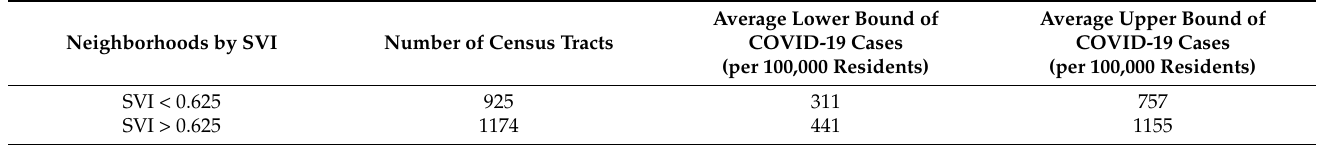
Figure 1. SVI and COVID-19 infection rates on 8 April 2020 in The Bronx, Brooklyn, Manhattan, and Queens (red dots indicate study locations): ( a ) SVI ratings (blue, more vulnerable; yellow, less vulnerable) [7]; ( b ) total counts of COVID-19 by case ranges by zip code [10]. Table 1. New York City SVI information [9] compiled from Figure 1